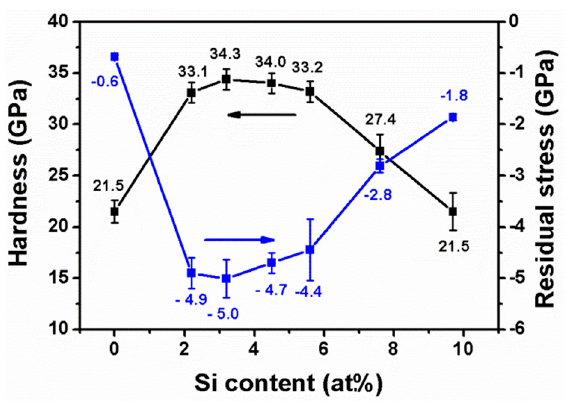
Figure 12. Nanoindentation hardness and residual stress values of Zr–Si–N films.